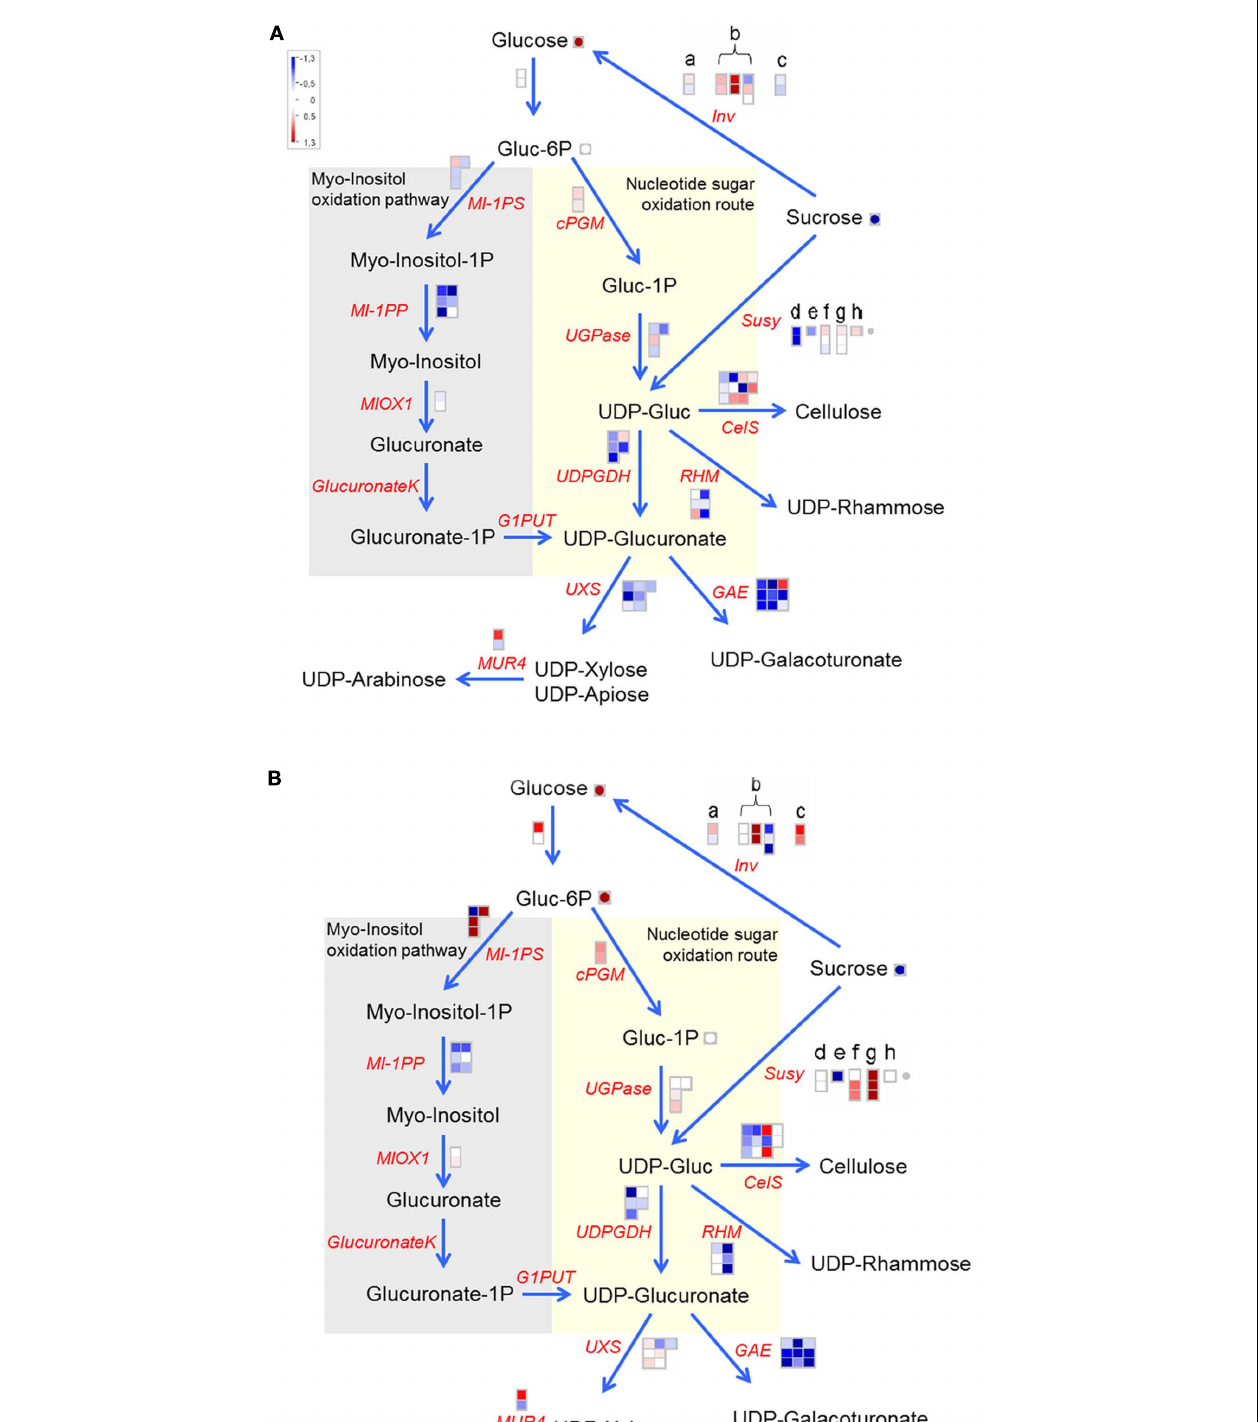
FIGURE 4 |The production of UDP-glucose and UDP-glucuronate for cell wall biosynthesis in (A) U-IN-1 and (B) U-IN-2. (a) Neutral invertase. (b) Cell wall invertase (c)Vacuolar invertase. (d–h) differentially expressed Susy Isoforms with (d) Susy4. Gene name abbreviations: MI-1PP,